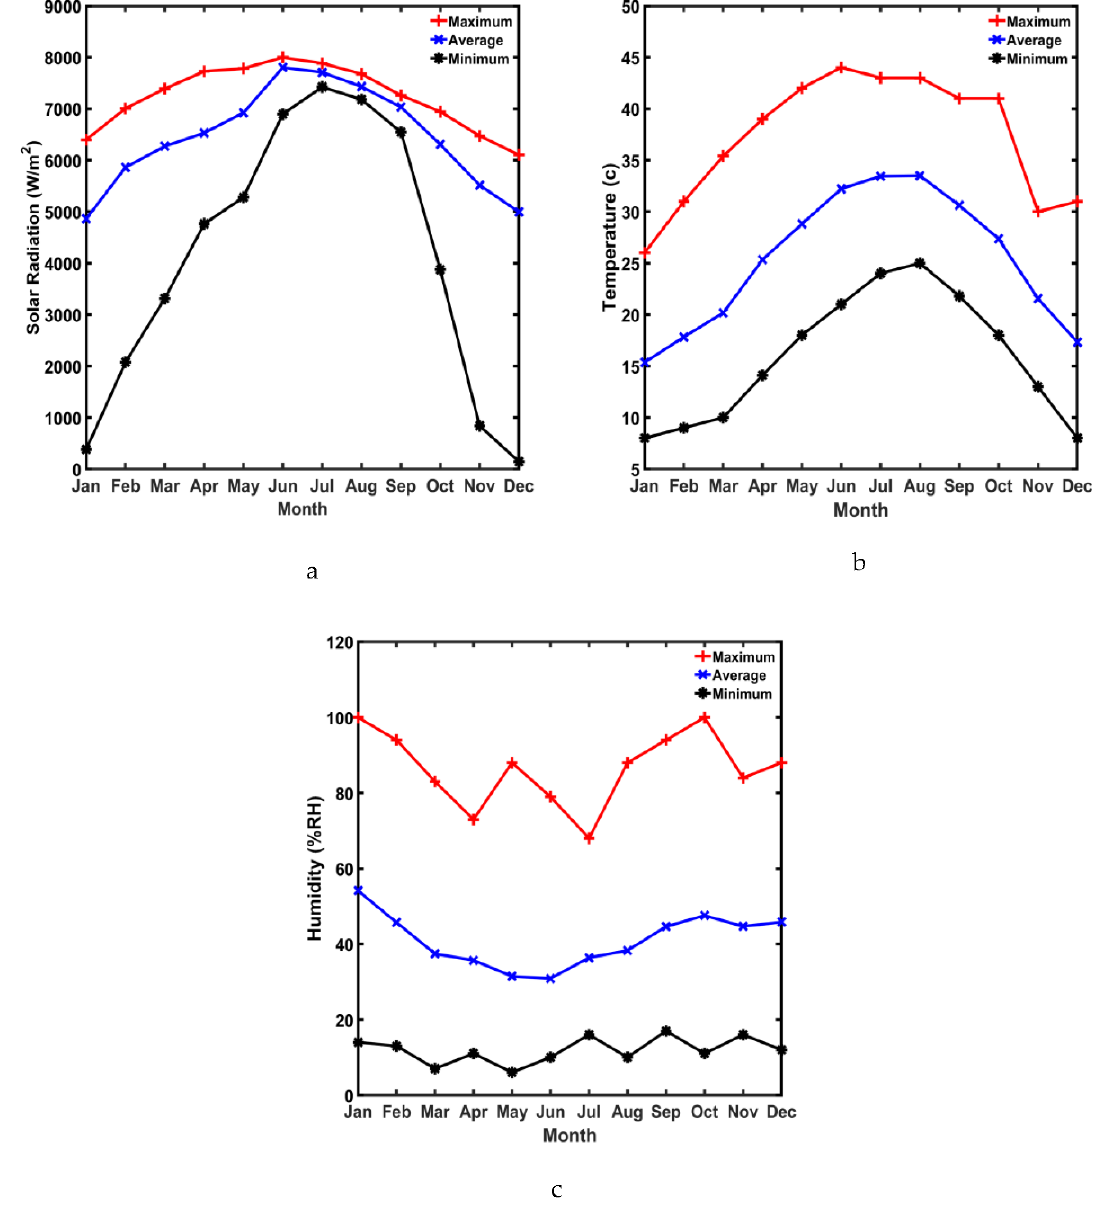
Figure 4. Monthly weather data (maximum, minimum and average) profiles for: ( a ) solar Irradiation, ( b ) temperature, and ( c ) humidity.